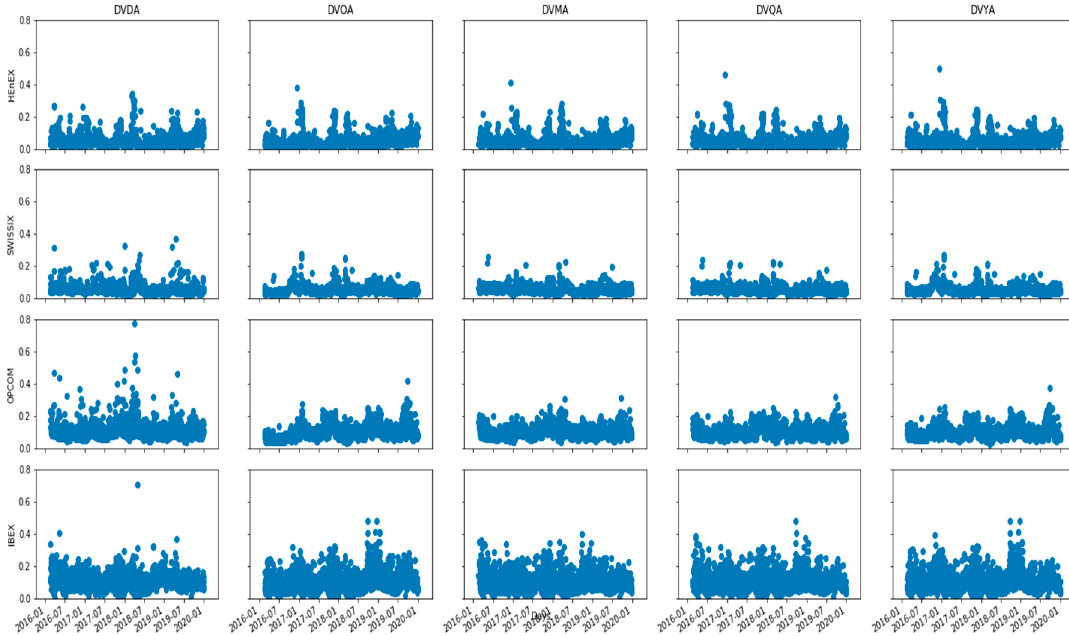
Figure 1. Price volatility DVOA, DVYA, DVQA, DVMA and DVDA for four selected markets.